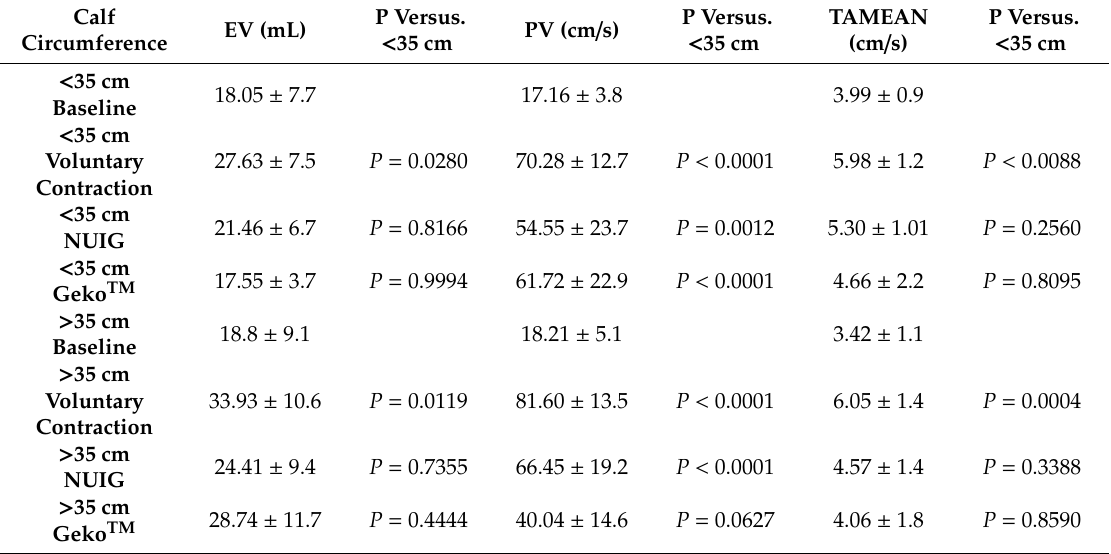
Table 2. Summary of results from all interventions and parameters measured.